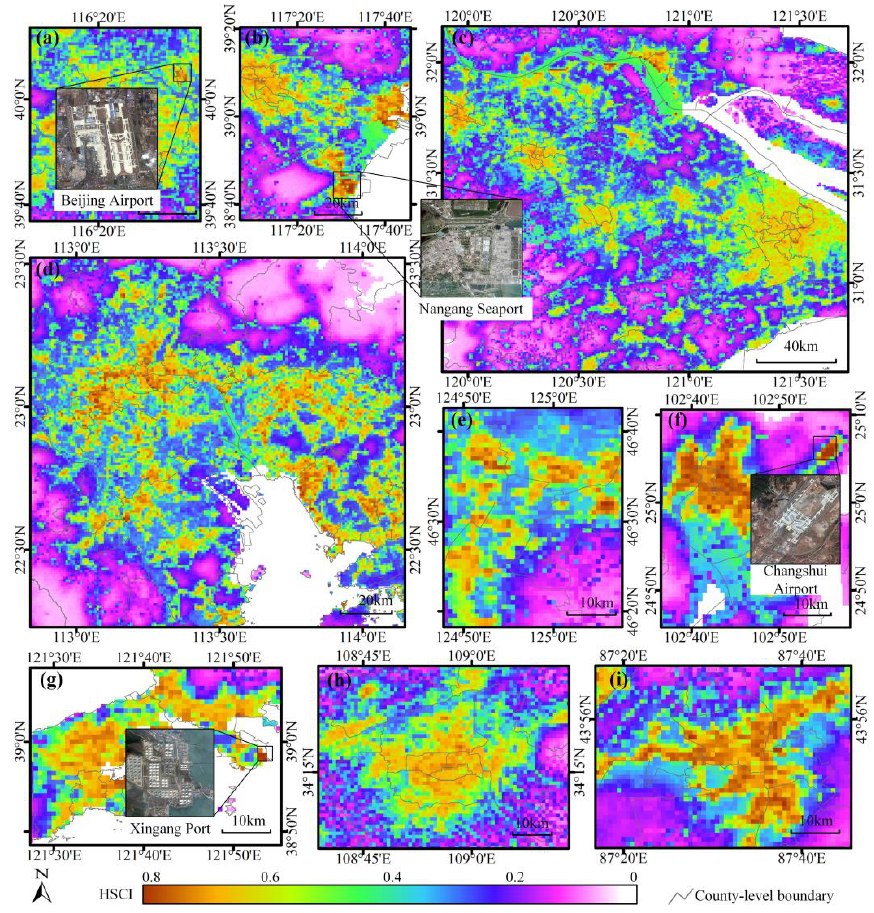
Figure 6. Spatial patterns of HSCI-based human settlements across different regions in China. ( a ) Beijing; ( b ) Tianjin; ( c ) Yangtze River Delta; ( d ) Pearl River Delta; ( e ) Daqing; ( f ) Kunming; ( g ) Dalian; ( h ) Xi’an; and, ( i ) Urumqi.